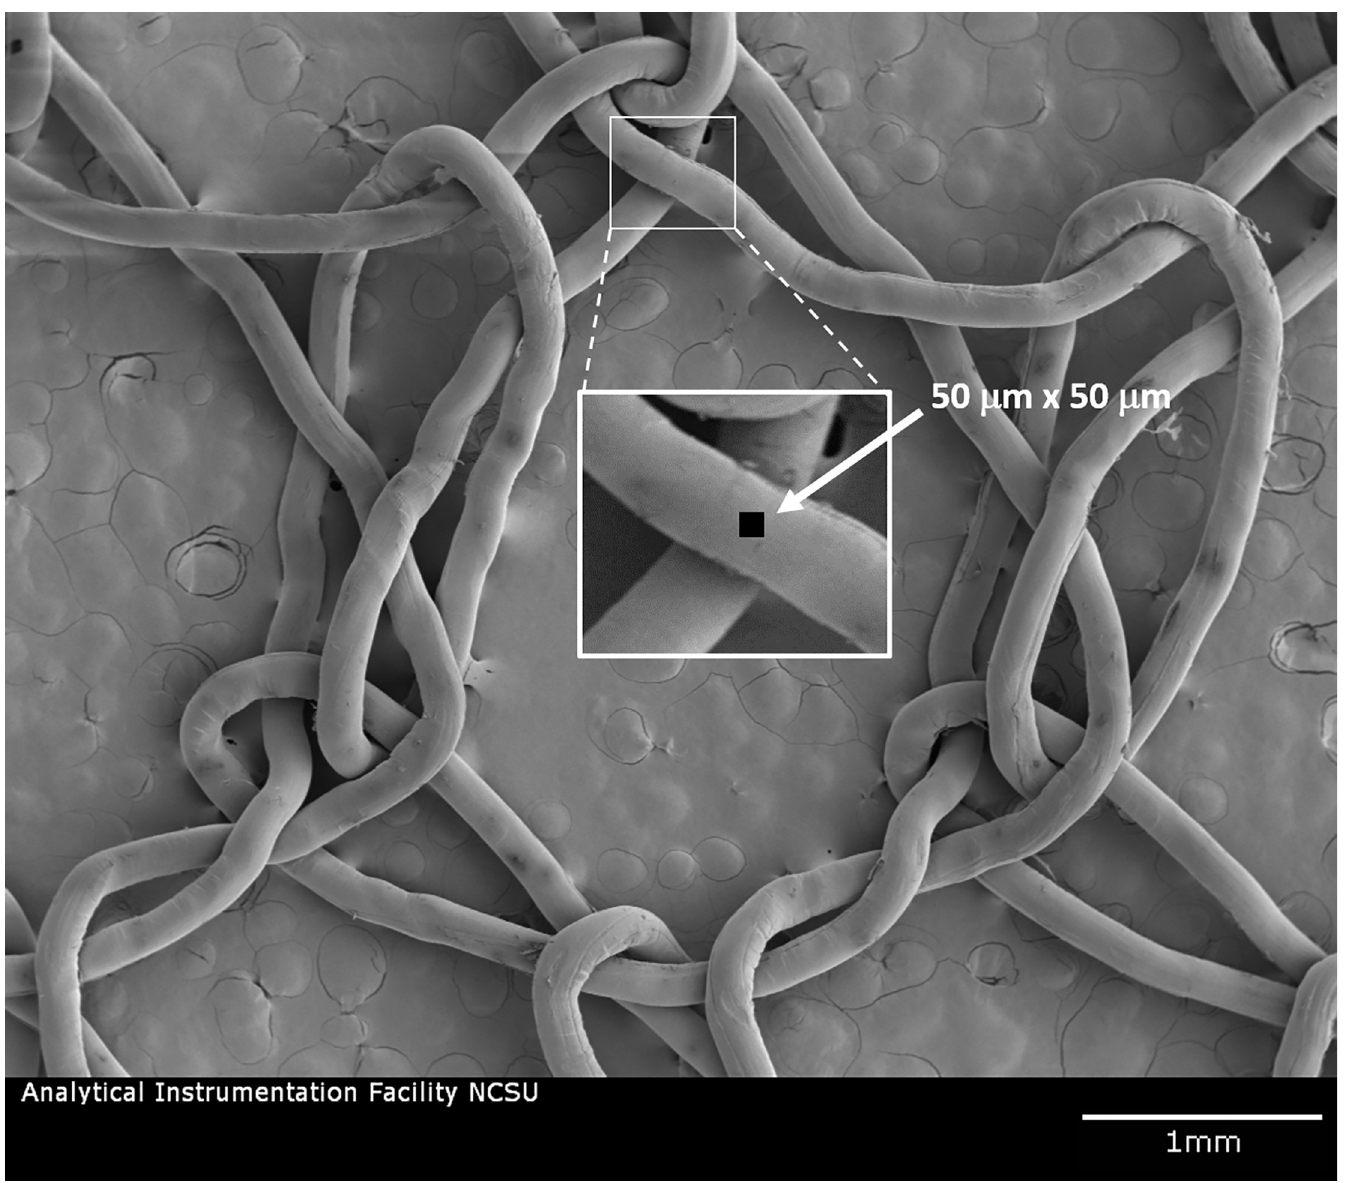
Fig 1. Scanning electron micrograph of Olyset netting illustrating the size of the fiber relative to a 50 μ m x 50 μ m analysis area. Image obtained at 5 kV after sputter coating the specimen with gold palladium.